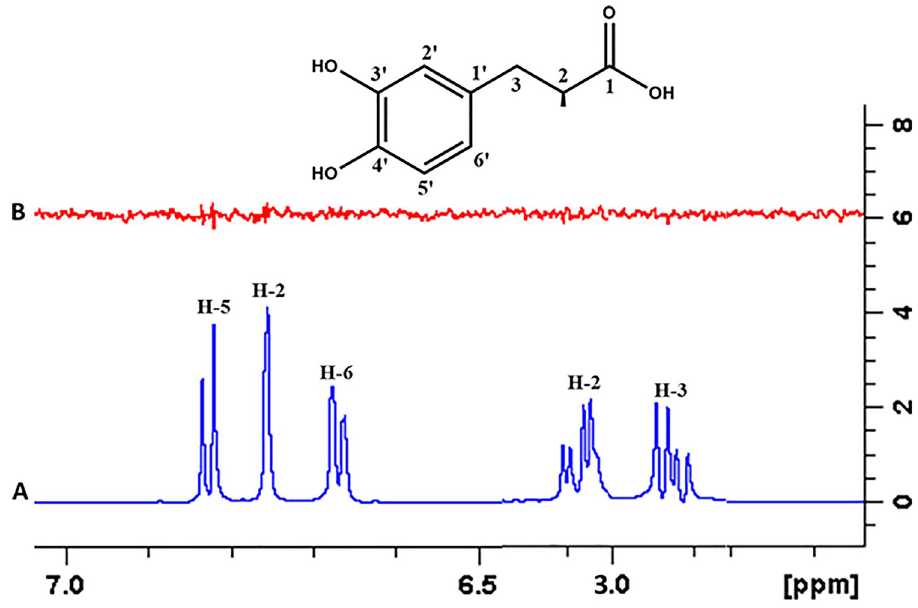
Fig 24. (A) Reference 1 H-NMR spectrum of ligand 29 . (B) Difference spectrum of ligand 29 with the enzyme.